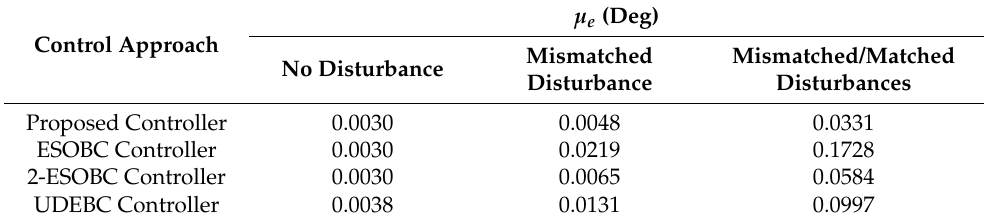
Table 4. The standard deviation of tracking errors in the steady-state phase.